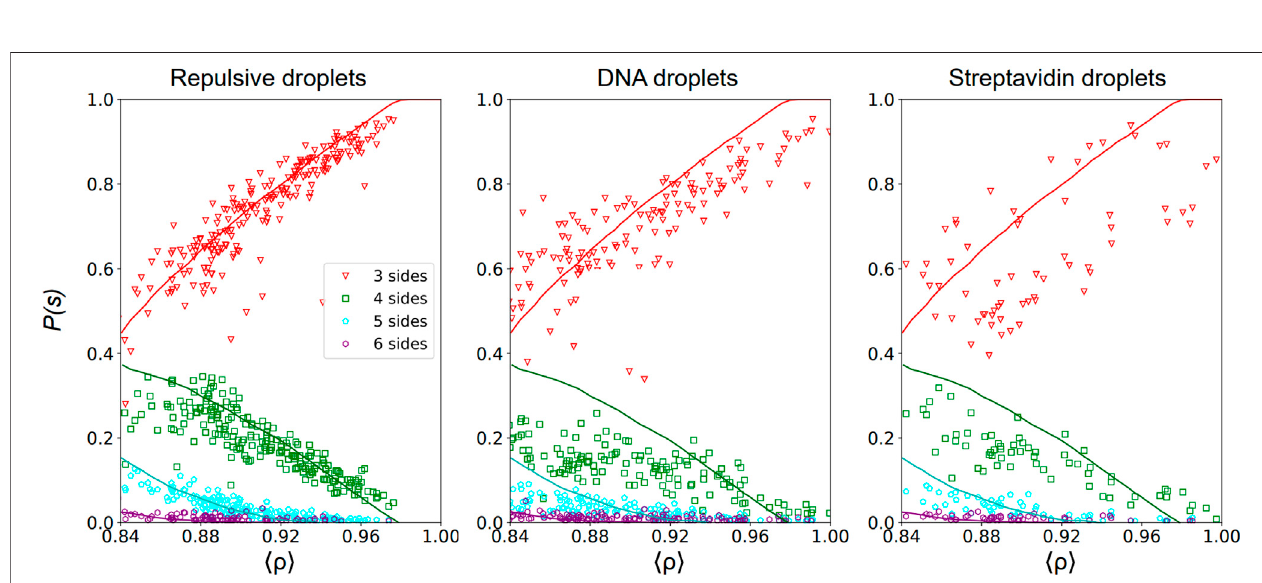
FIGURE 4 | Topology of the voids — Probability P ( s ) to have a void with s sides with s (cid:1) 3 (red triangles), 4 (green squares), 5 (cyan pentagons) and 6 (purple hexagons) as a function of the packing fraction 〈 ρ 〉 calculated as in Eq. 1 in 2D Packing images of repulsive emulsions (left) , DNA emulsions (center) and streptavidin emulsions (right) . The void probability is normalized such that (cid:1) s P s ( ρ ) (cid:1) 1 at each packing fraction. We superimpose on our experimental data results of numerical simulations of jammed packings in a deformable particle model introduced in [51].